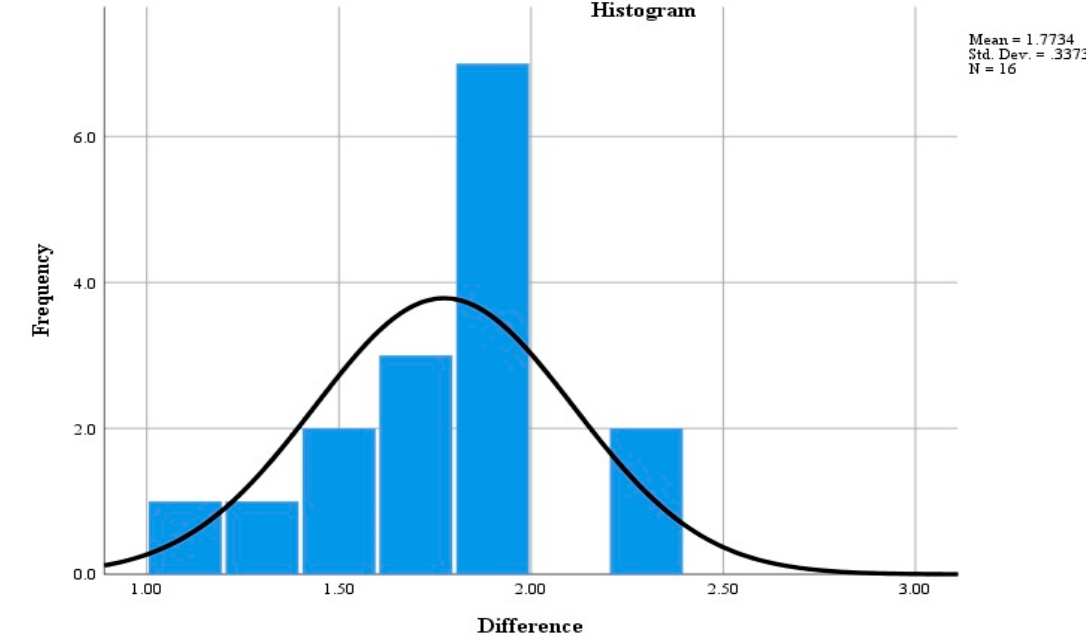
Figure 18. The normal analysis results.